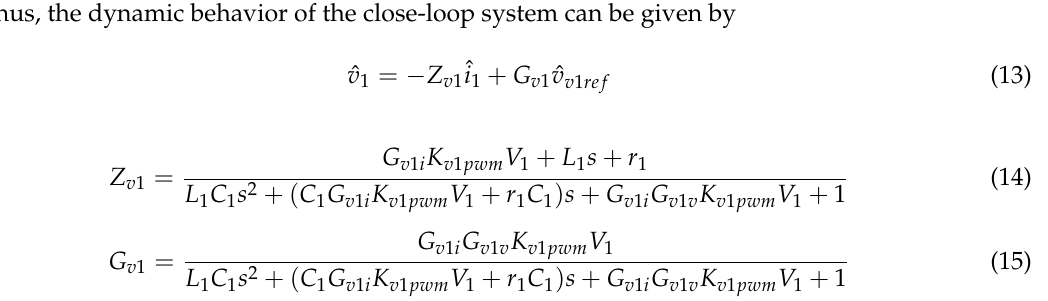
Figure 6. The small-signal block diagram of the multi-loop control system of the source.